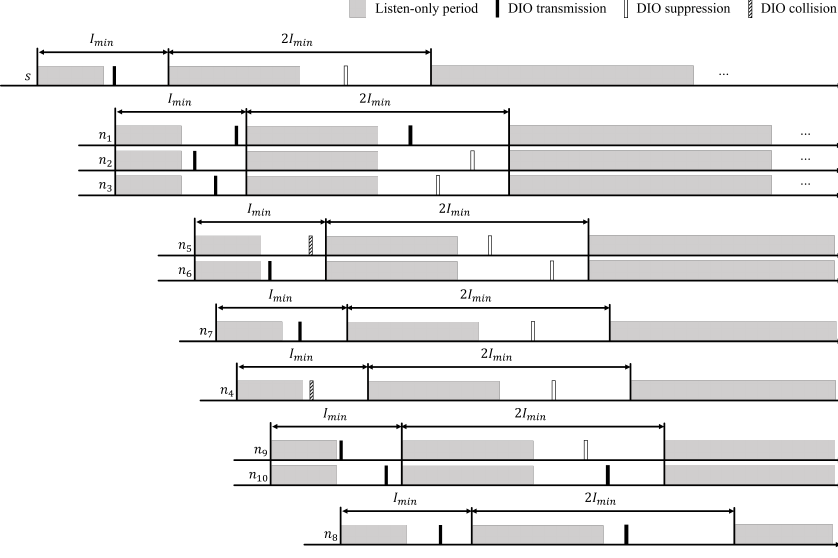
Figure 7. Standard trickle timer in 3D P2P-RPL.